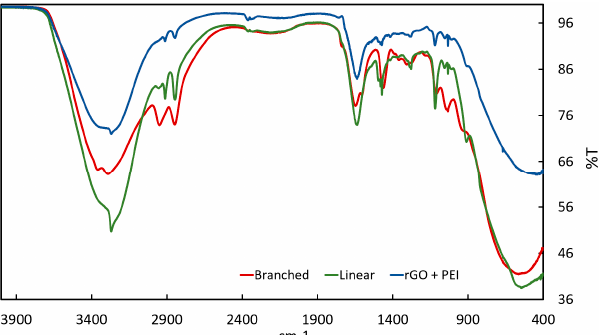
Figure 5. Infrared (IR) absorption spectroscopy result for the three deposited coatings on the quartz